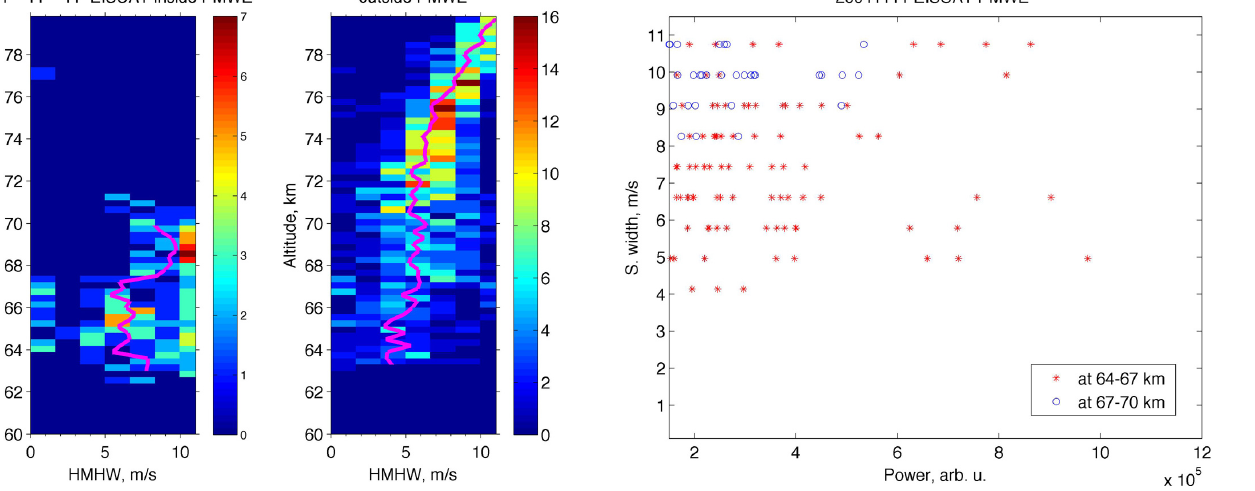
Fig. 6. Scatter plot of EISCAT PMWE spectral width versus backscattered power at 64–67km (red *) and 67–70km (blue o) altitude for 11 November